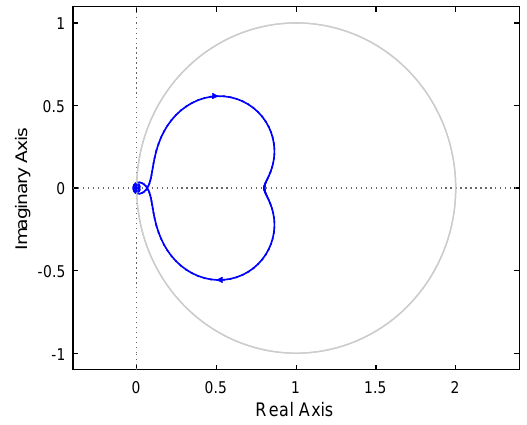
Figure 16: Graphical evaluation of the stability crite- rion for ILC applied to the DFB feedback